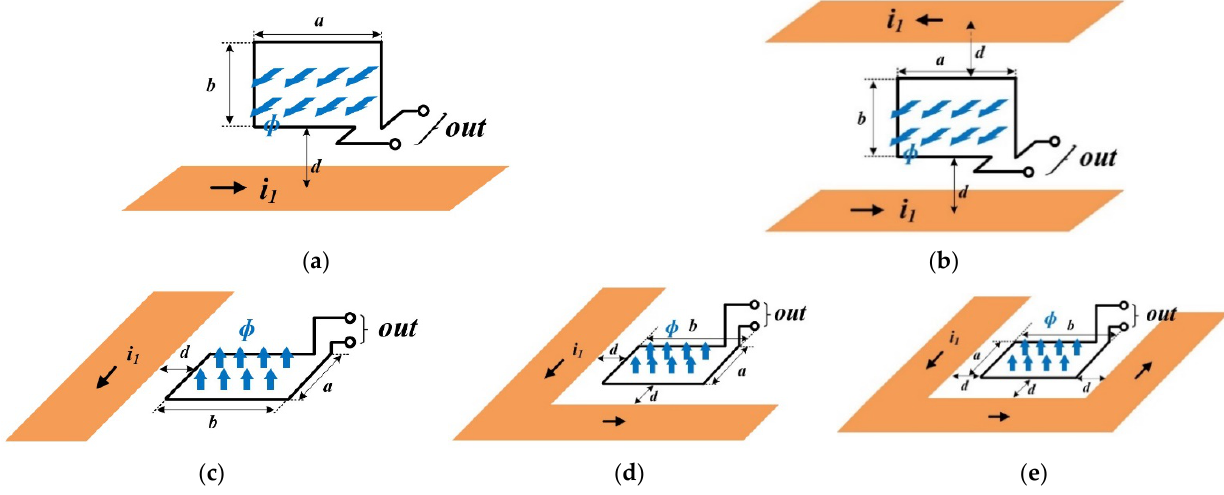
Figure 3. Geometry of ( a ) Model-A: vertical structure of a pickup coil with conductor trace on one side; ( b ) Model-B: vertical structure of a pickup coil with conductor trace on two sides; ( c ) Model-C: horizontal structure of a pickup coil with conductor trace on one side; ( d ) Model-D: horizontal structure of a pickup coil with conductor trace on two sides; and ( e ) Model-E: horizontal structure of a pickup coil with conductor trace on three sides.